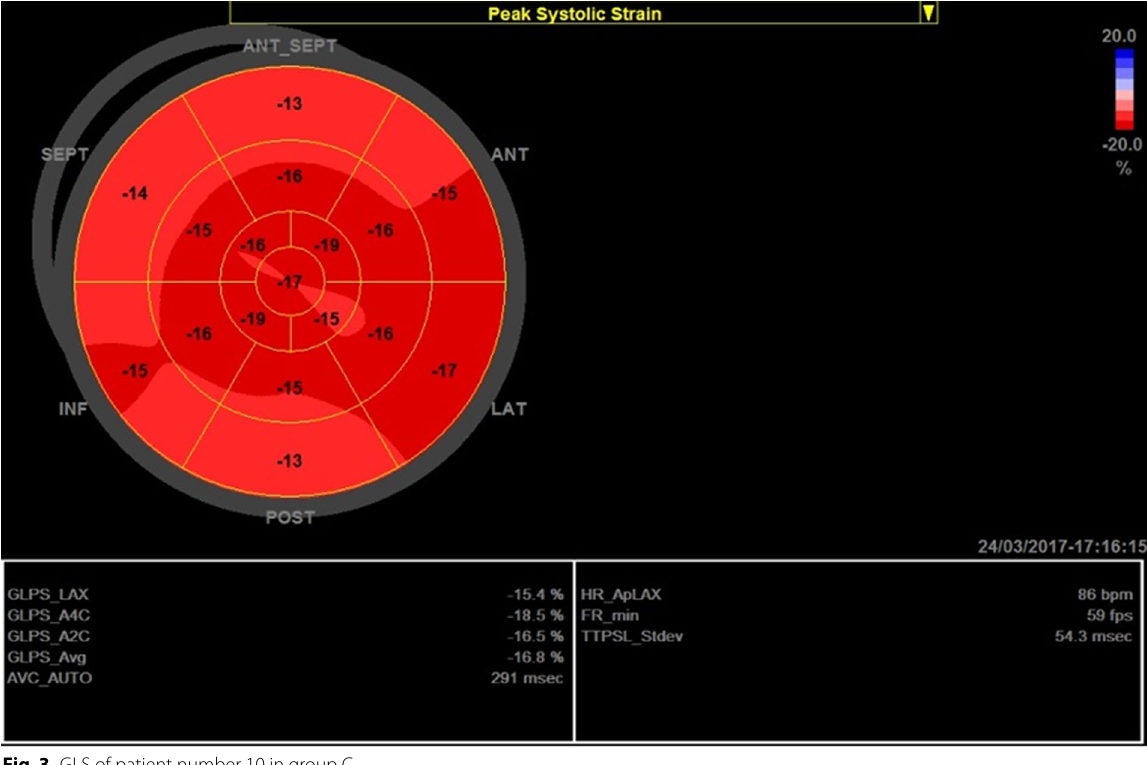
Fig. 3 GLS of patient number 10 in group